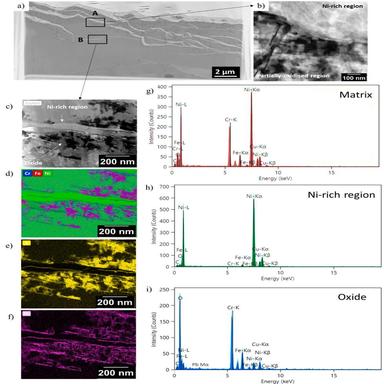
Pb-caustic SCC crack flanks extracted from a post-test fracture surface (5000 ppm of PbO in 0.3 M NaOH). (a) FIB mixed SE+BSE image of the lamella corresponding to the dotted region in, prior to thinning procedure, where two areas of interest (A and B) are indicated. (b) Area A: magnified HAADF STEM image of a particulate structure beneath a Ni filament. Area B: (c) HAADF STEM image and corresponding elemental maps for (d) Ni Kα (green), Fe Kα (red) and Cr Kα (blue) combined (e) O Kα, (f) Pb Mα